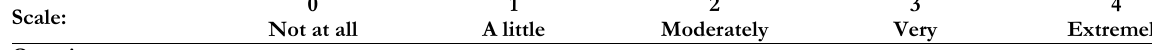
Table 1. Pre and Post-Survey of Teachers’ Comfort with STEM